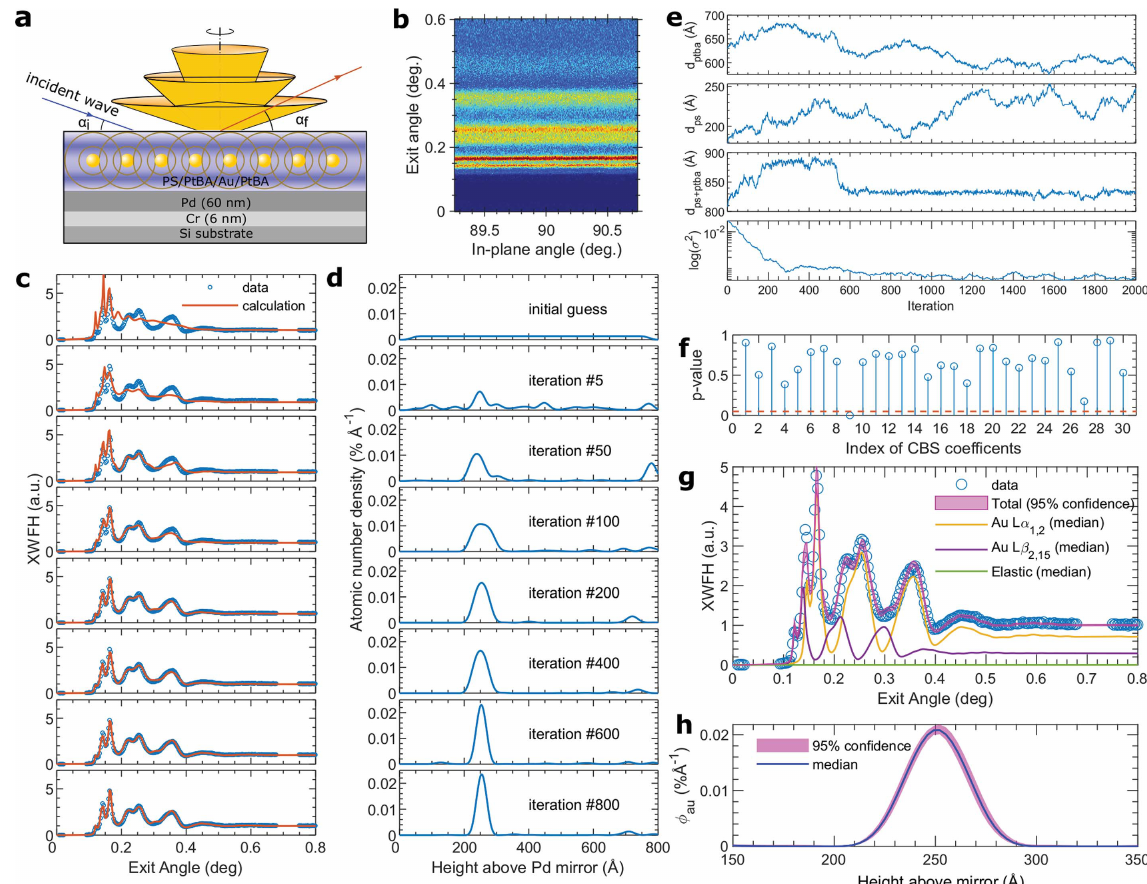
Figure 5 ( a ) Schematics of the thin-film waveguide and principle of the X-ray waveguide fluorescence holography. The meanings of involved parameters to be optimized for are described in the text. ( b ) Fluorescence hologram on an area detector mounted in the plane of the film surface at a right angle with respect to the incident plane. The hologram is integrated in the horizontal plane to obtain the one-dimensional intensity profile as a function of the exit angle (cid:6) f . Panels ( c ) and ( d ) are, respectively, the calculated XWFH and corresponding Au atomic number density profiles at different HMCMC iterations. ( e ) Traces of PtBA layer thickness d ptba , capping PS layer thickness d ps , total film thickness d ps+ptba , and the residual variance. ( f ) p -values of the 30 CBS coefficients calculated from the last 1400 iterations. The dashed red line corresponds to a p -value of 0.05, i.e. a significance level of 95%. ( g ) 95% confidence interval of the total XWFH, and median (50% percentile) contributions from the Au L (cid:6) 1,2 , Au L (cid:7) 2,15 , and elastic scattering background. ( h ) 95% confidence of the Au atomic number density distribution profile. The solid line is the